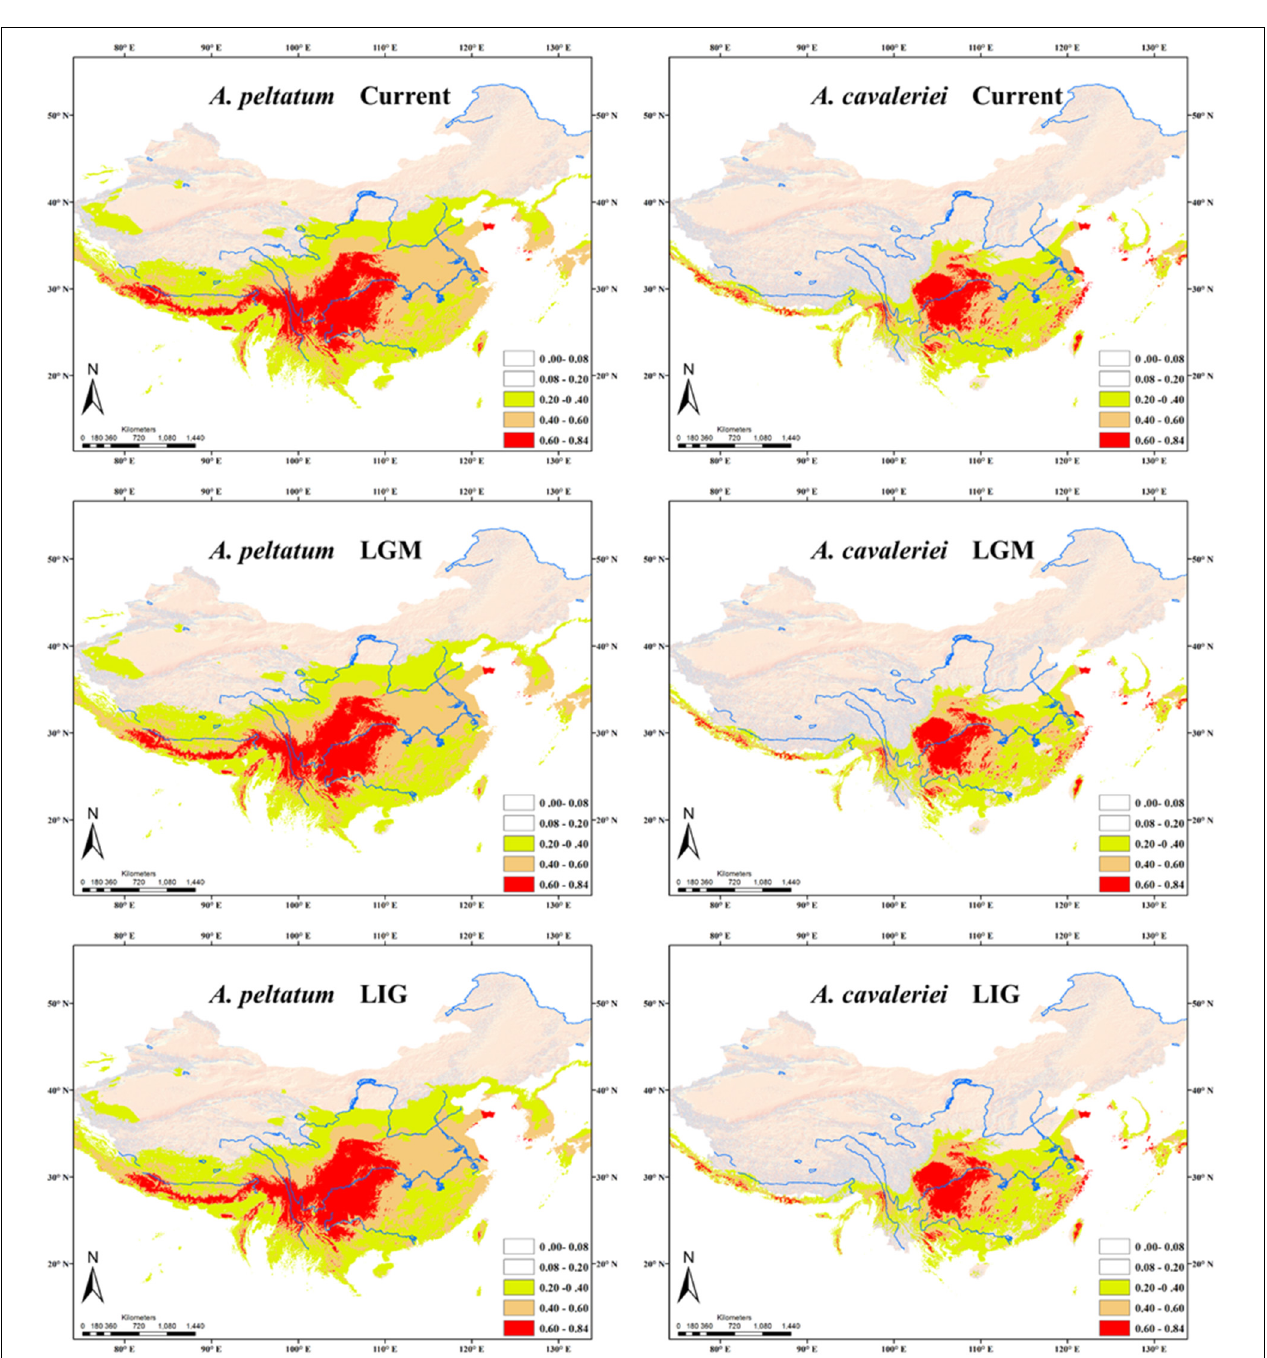
FIGURE 6 | Predicted distributions of Asteropyrum using ecological niche modeling. LGM, the Last Glacial Maximum; LIG, the Last